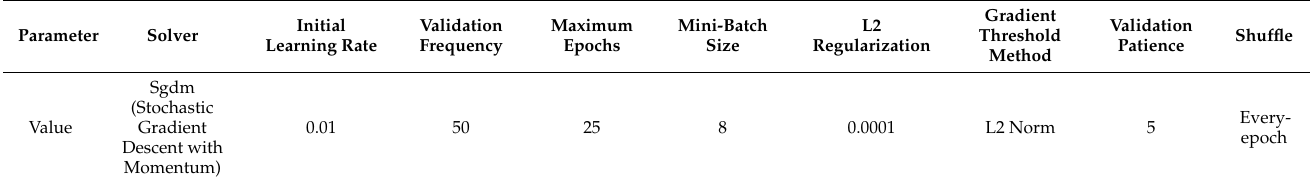
Table 4. Network Training